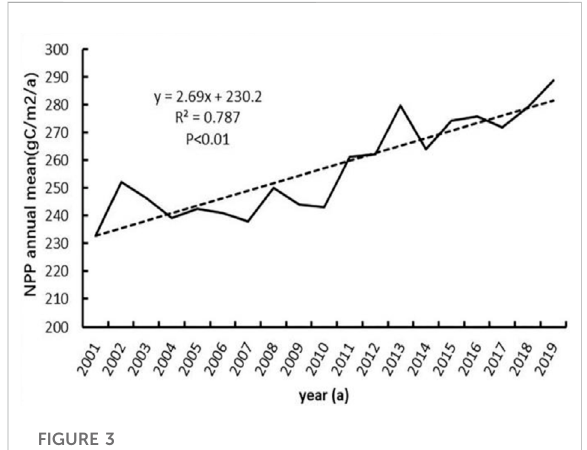
FIGURE 3 Interannual variation of grassland NPP in China (excluding Hong Kong, Macao and Taiwan) from 2001 to 2019.